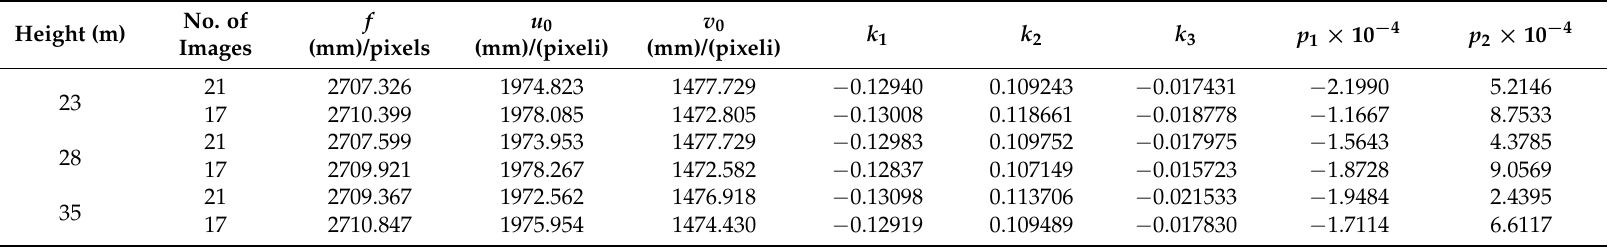
Table 6. Interior orientation parameters calculated for the “GoPro” digital camera at 3 different heights: 23 m, 28 m, and 35 m using “3DF Zephyr Pro” software. No. Height (m)